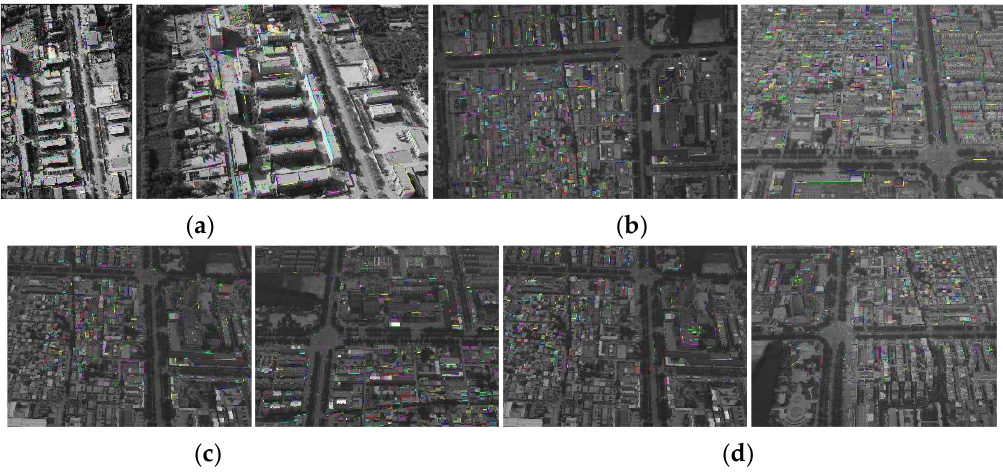
Figure 14. The matched line segments after back-projection to the original images. ( a ) The matched